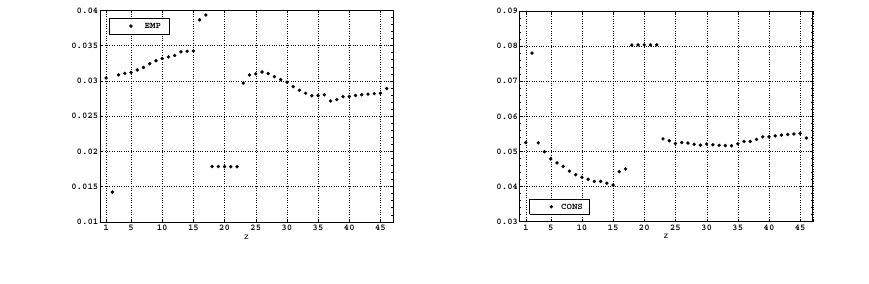
Figure 1. Indicator EMP weights. Figure 2. Indicator CONS